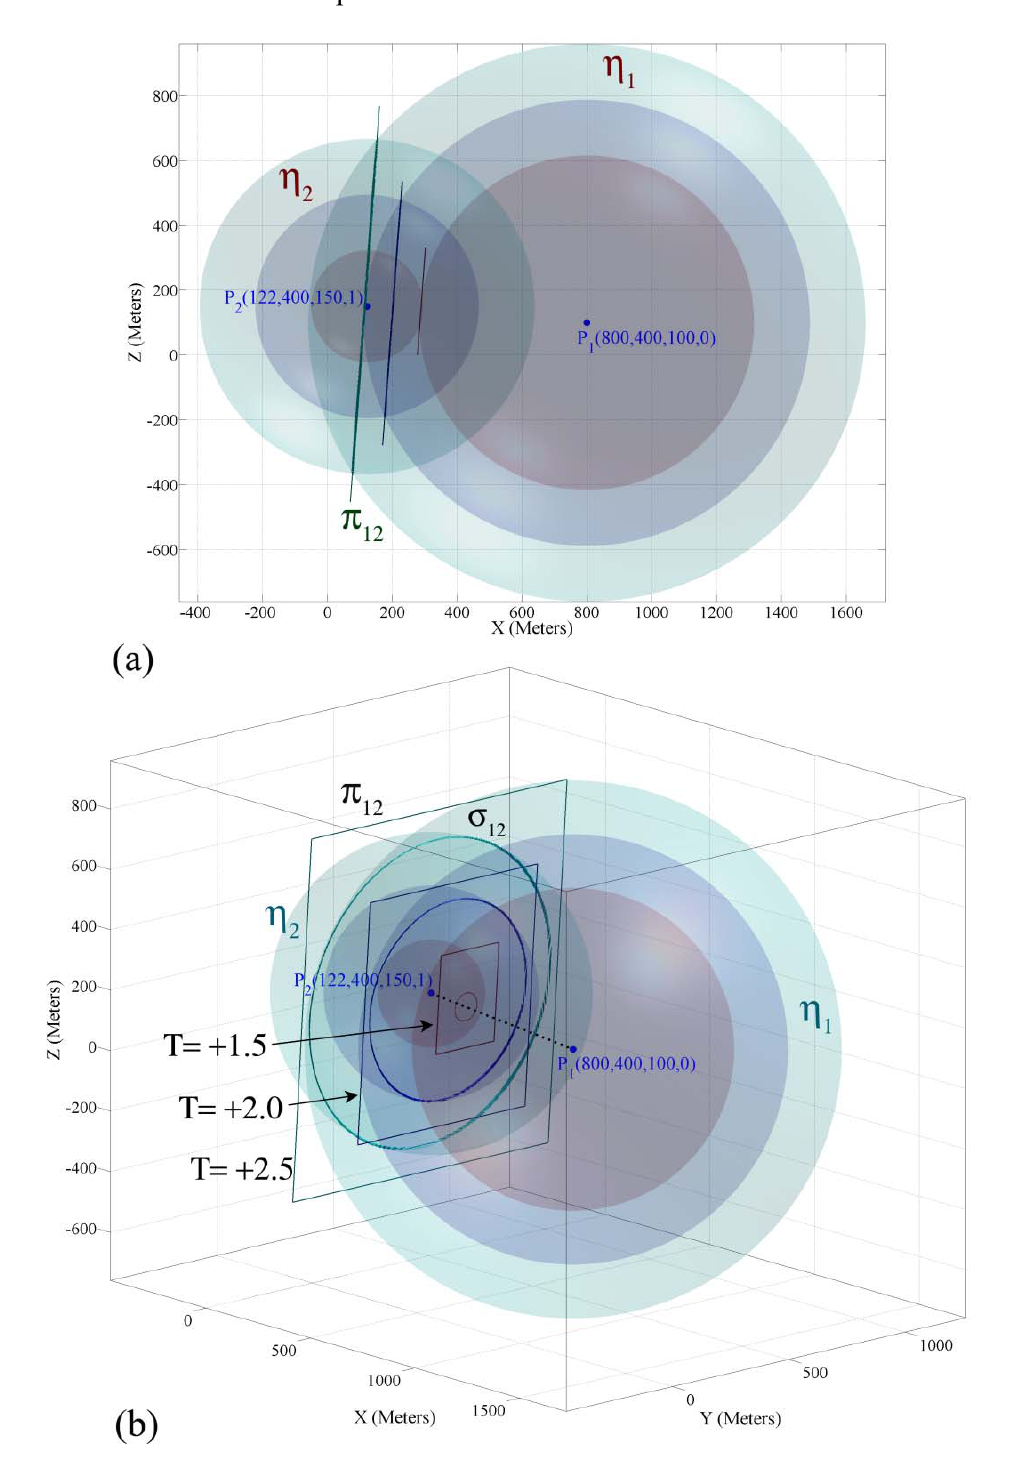
Figure 3. (a) The intersection hyperplanes of two double hypercones at three different points in time. (b) The intersection of two 4-dimensional double hypercones of target localization in 3-dimensional